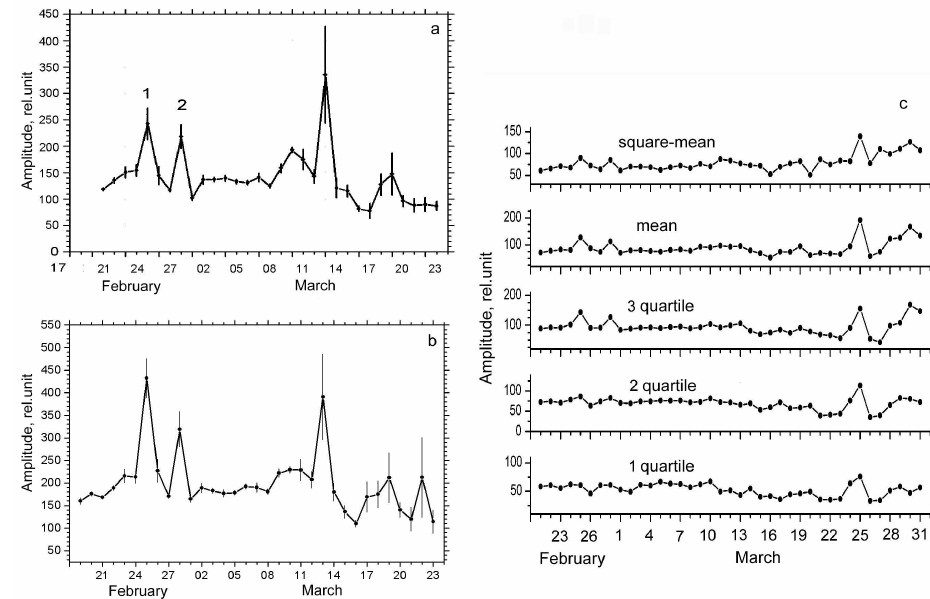
Fig. 2. The variations of the AA for the monthly period (February–March) obtained using (a) the methods of one-point lightning location finding and with (b) a correction of the distance to the lightning using the data of the WWLLN network. The variations of the AA at hours of maximum thunderstorm activity 16:00–17:00 LT from (c) advanced azimuthal sector corresponding to the fifth Fresnel